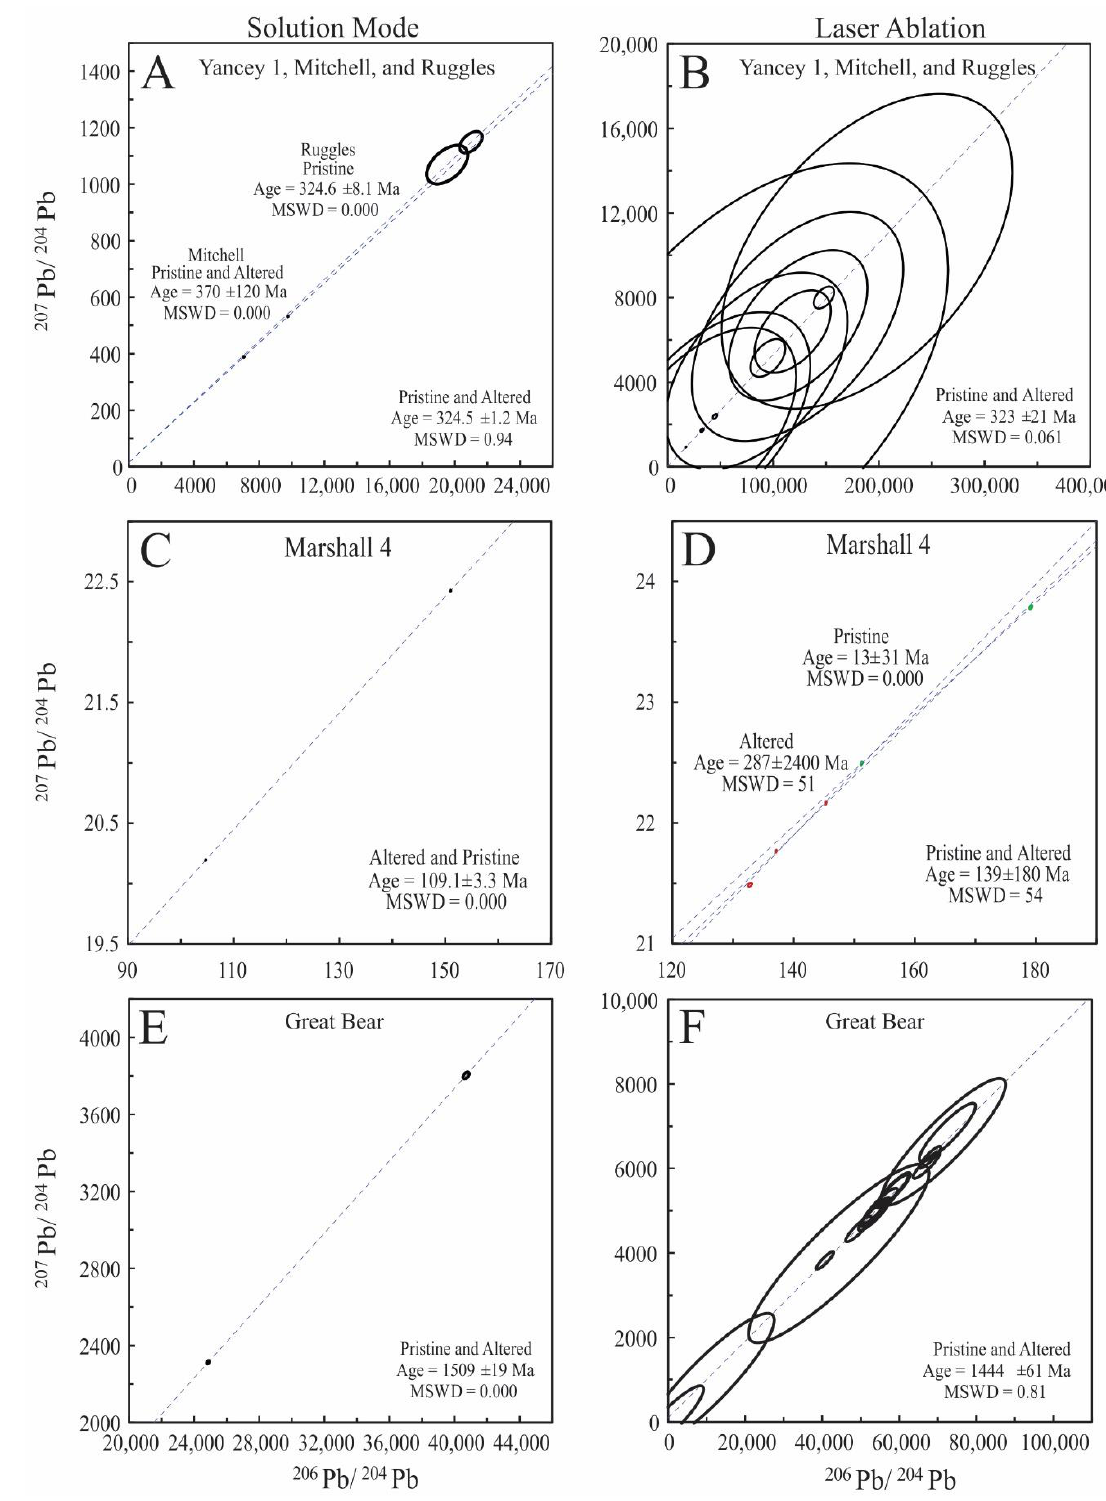
Figure 2. Secondary Pb-Pb isochrons of selected uraninite, investigated in this study. ( A , C , E ) represent analyses obtained using SM-MC-ICP-MS; whereas ( B , D , F ) illustrate results acquired by LA-MC-ICP-MS. ( A , B ) compare age results between pristine and altered uraninite sections from Yancey 1, Mitchell, and Ruggles, ( C , D ) compare ages for pristine and altered regions of uraninite from Marshall 2, and ( E , F ) show dating results for uraninite (pristine and altered) from Great Bear region.